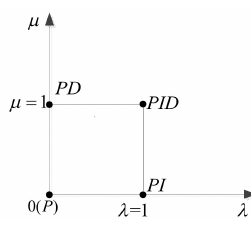
Figure 4. Range of IOPID and FOPID